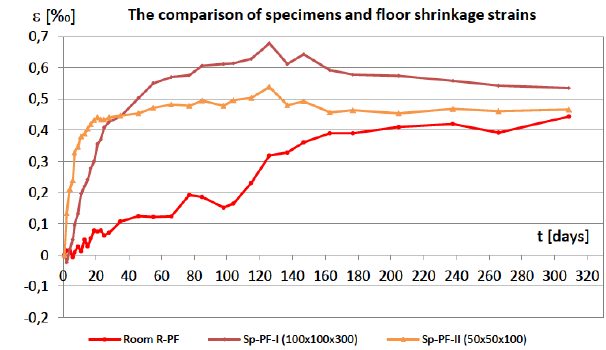
Figure 6: Graph of average increases in shrinkage strain measured on laboratory specimens along with graph of humidity and tempera- ture changes